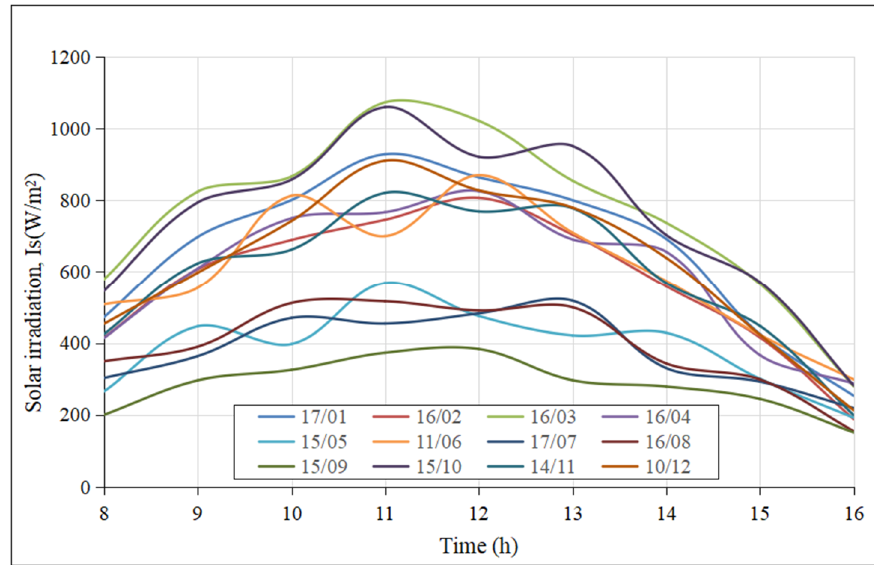
Figure 8. Solar radiation intensity of typical days of the year.